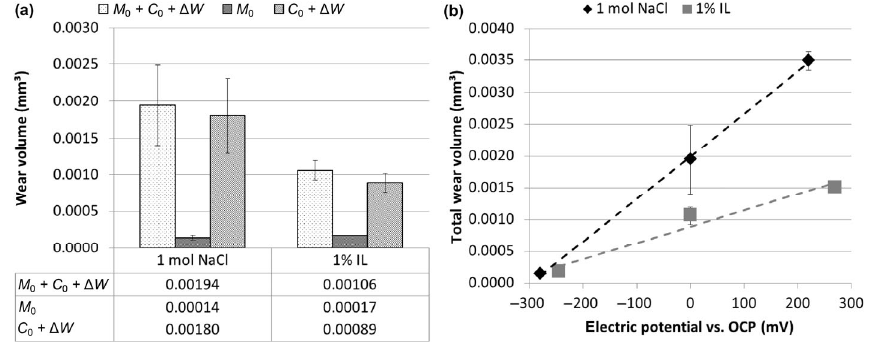
Fig. 5 (a) Determination of wear components based on dynamic corrosion model; (b) Correlation of total wear volume and galvanically induced electric potential.